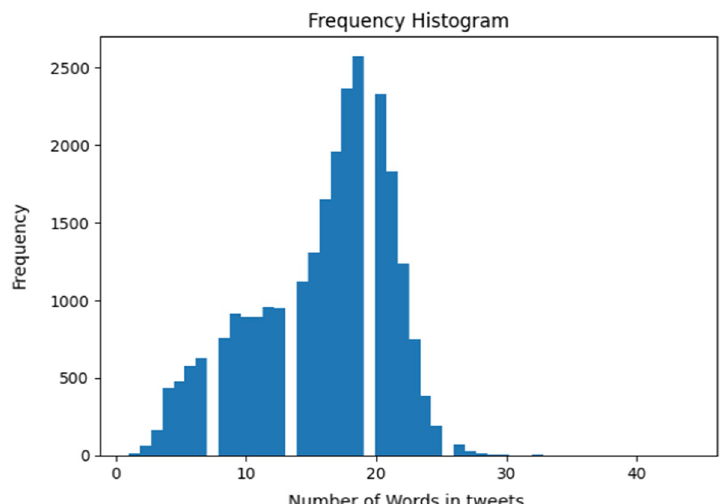
Fig. 2 Frequency of number of words in tweets